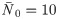
Time series for the simulated distribution of the population composition x.The distribution initially broadens, then freezes to a steady state (see S1 Video). The fraction of populations that have x = 0 or x = 1 (indicated by the black bins) remains constant during the time evolution, as expected for a Pólya urn process, and in contrast to expectations from genetic drift (see S1 Table). In each well the population follows a stochastic path and reaches a (random) limit composition, and the distribution freezes only when all populations reached their limit. The parameter values used in the simulation are N‾0=10 and x‾0=0.33 The inset shows the mean, standard deviation and skewness as a function of the number of generations, with symbols denoting numerical simulations, and the solid lines corresponding to the theoretical prediction of Eq (2) (and also those in S2 Text). Analytical and numerical values agree. The mean ⟨x⟩ remains constant throughout the evolution, as expected for a non-selective process; standard deviation and skewness saturate to limit values, confirming the freezing of the distribution.